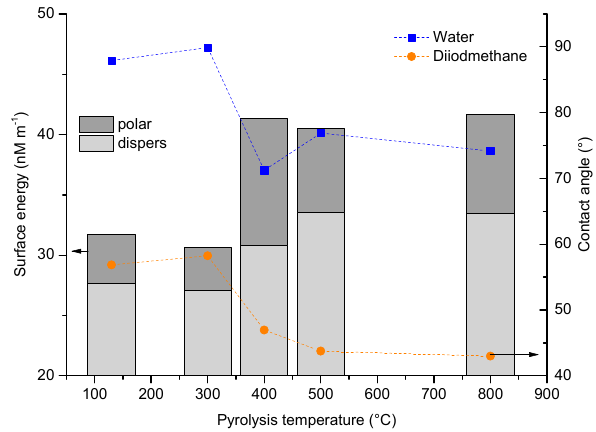
Figure 10. Contact angle of water and diiodomethane and the free surface energy as a function of the pyrolysis temperature of the PDC material.